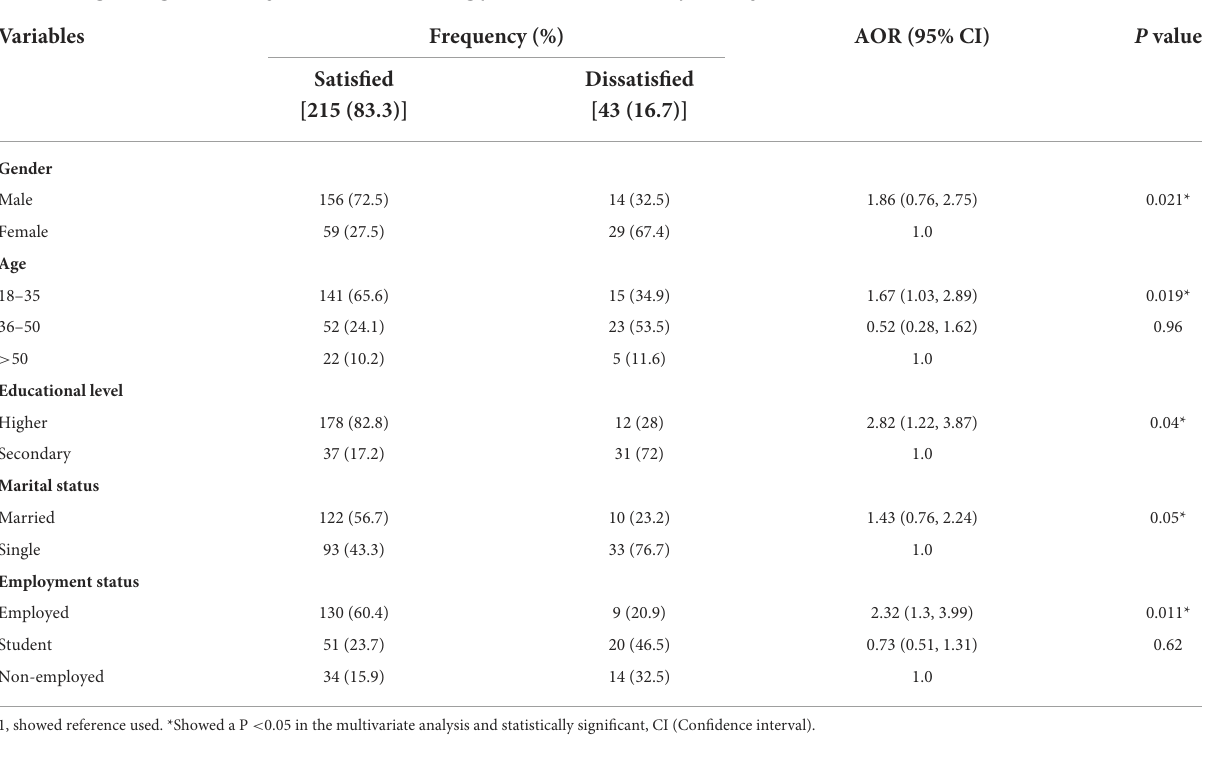
TABLE 6 Logistic regression analysis of factors influencing patients’ satisfaction on pharmacy services ( n = 258).